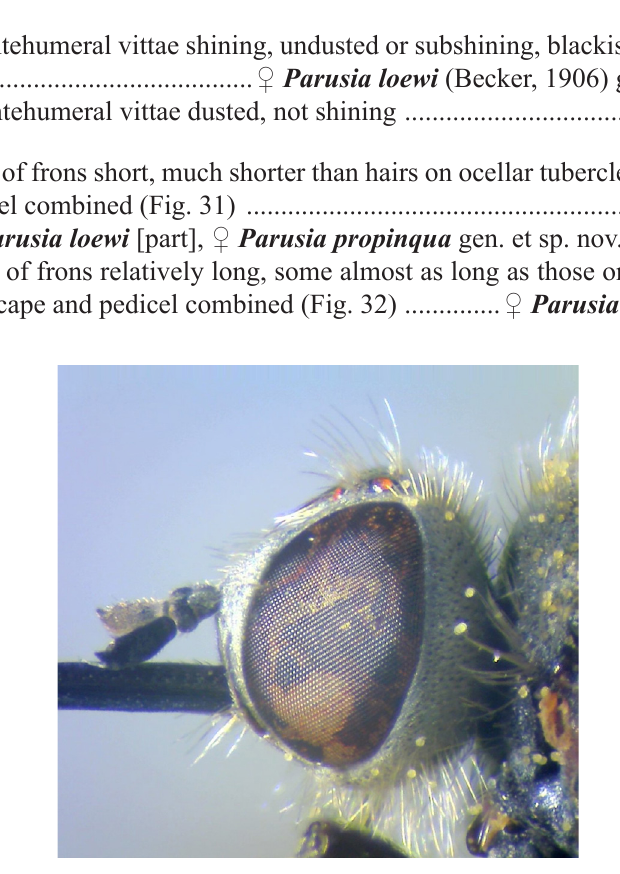
Fig. 31. Parusia loewi (Becker, 1906) gen. et comb. nov., ♀.